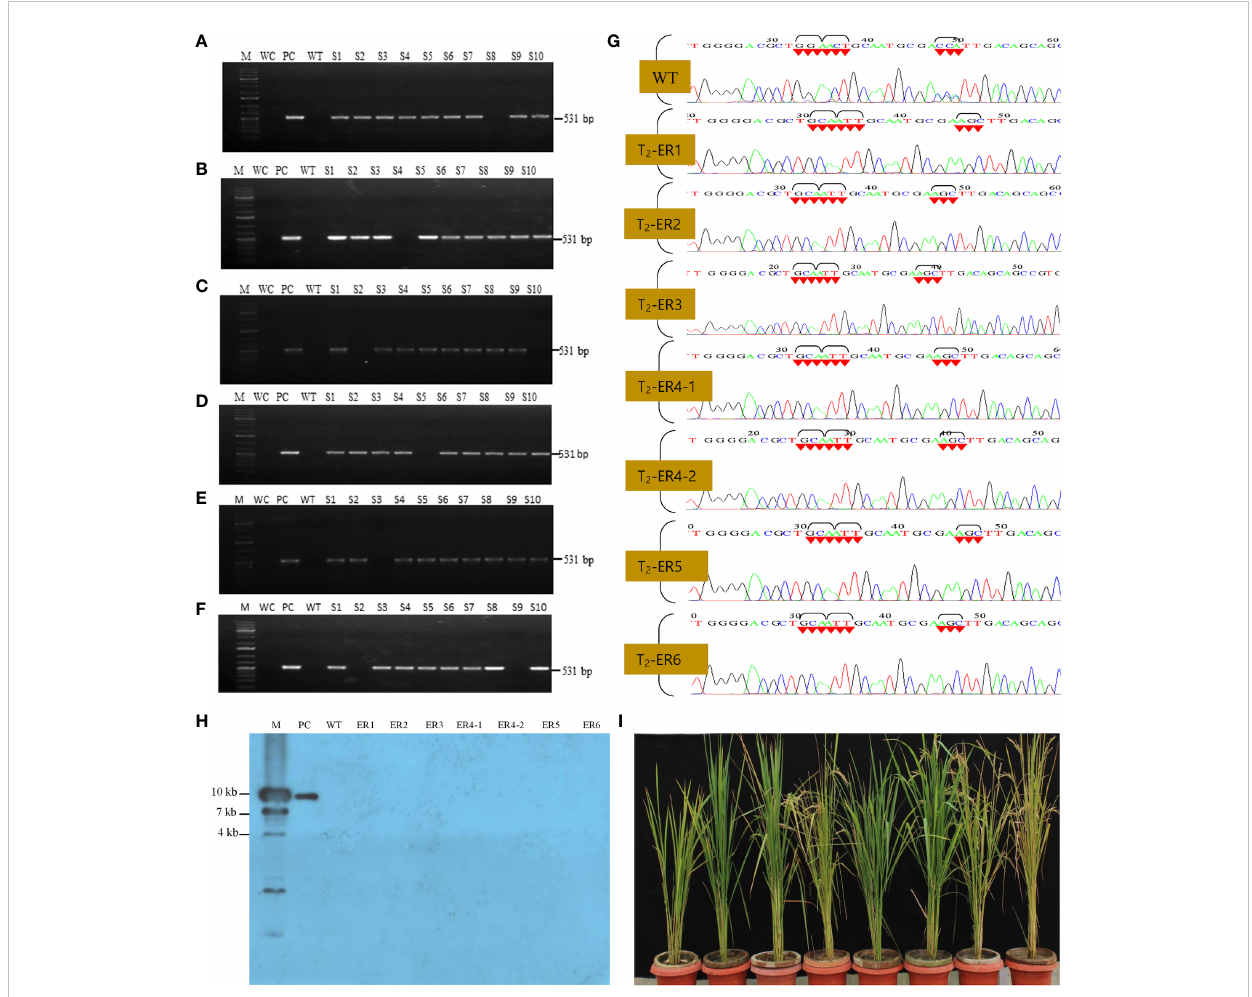
FIGURE 4 Molecular validations of Cas9-free edited rice lines. (A – F) PCR-based identi fi cation of Cas9-free rice edited lines using Cas9 primers, where M, 1-kb DNA ladder; WC, water control; PC, positive control (Cas9 harboring plasmid). The lane S1 – S10 samples from each edited rice lines. (G) Sanger sequencing of edited rice lines (T2 generation). Sequence chromatogram showing WT and modi fi ed EPSPS gene [glycine (GGA) to alanine (GCA), threonine (ACT) to isoleucine (ATT), and proline (CCA) to serine (AGC)]. (H) Southern blot analysis for the identi fi cation of Cas9-free segregates. In lanes S1-S7, no signal were detected, con fi rming the presence of Cas9-free T2 segregates, where M, marker; PC, positive control (Cas9); WT, wild-type plant. (I) Cas9-free edited rice lines in green house